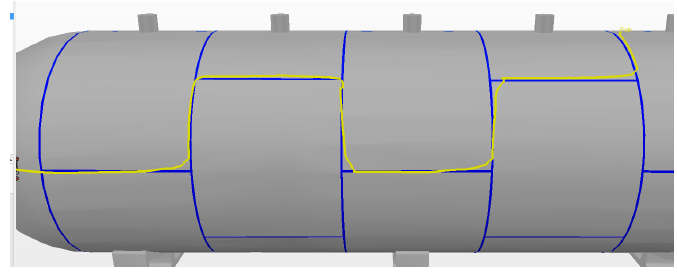
Figure 27. Sliding Autonomy experiment.